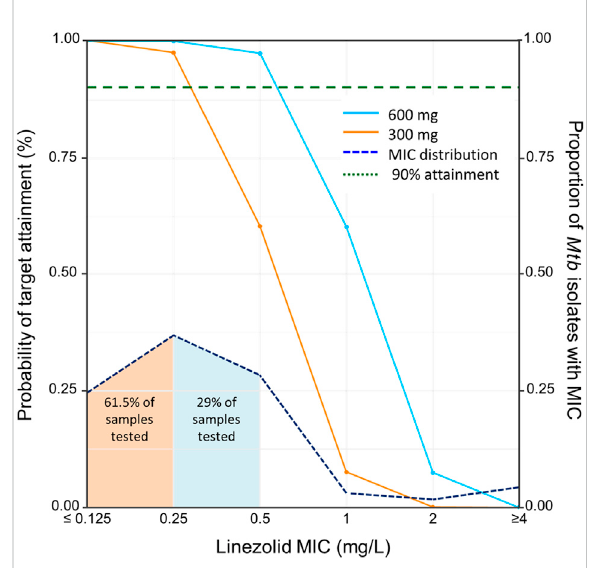
FIGURE 3 Probability of target attainment by dose and minimum inhibitory concentration. Solid lines indicate the probability of target attainment (PTA) on the primary y -axis (on left) based on area under the curve of unbound linezolid divided by MIC ( f AUC/MIC), adjusting for the linezolid minimum inhibitory concentration (MIC) on the X -axis. Lines indicate simulated doses of 600 mg once daily (blue solid line) and 300 mg once daily (orange solid line). The horizontal dashed green line indicates the 90% of attainment when f AUC/MIC ≥ 100. The dot-dashed line indicates the distribution of linezolid MIC of Mycobacterium tuberculosis isolatescultured from 166 study participants,with the proportion of all tested isolates with each MIC indicated on the secondary y -axis(onright).Theshadedareaunderthedot-dashed line indicates the proportion of tested samples with the corresponding MIC (color indicates that of the lowest dose with PTA > 90% for that